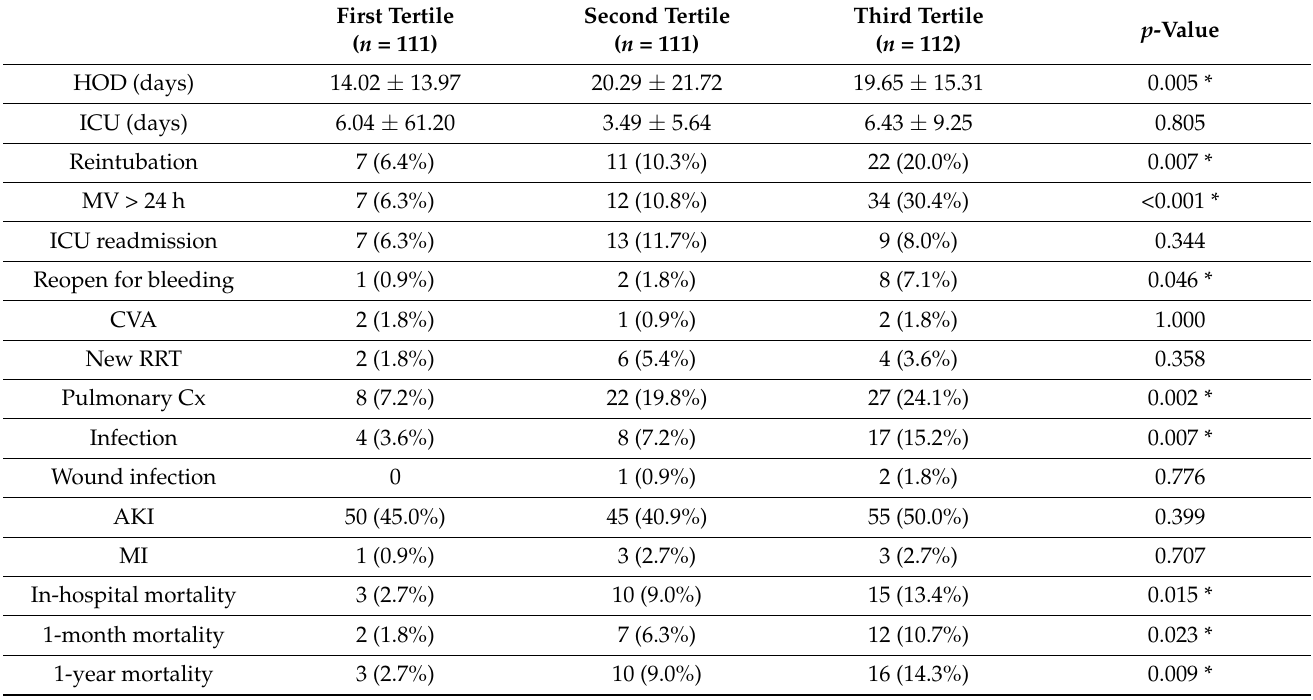
Table 3. Postoperative morbidity and mortality across three NLR